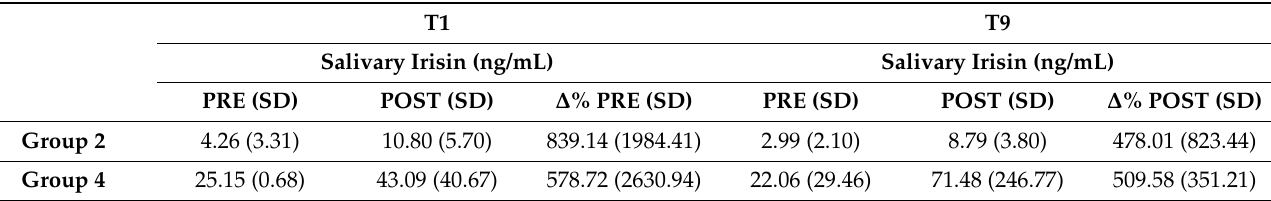
Table 6. Salivary irisin levels PRE and POST at Time T1 and T9. T1 T9 Salivary Irisin (ng/mL) Salivary Irisin